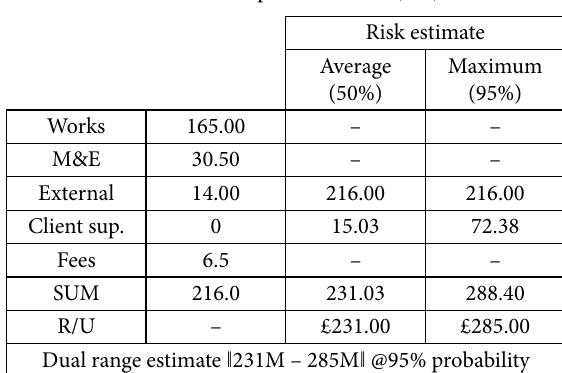
Table 2. Exemplar basic data (£M)